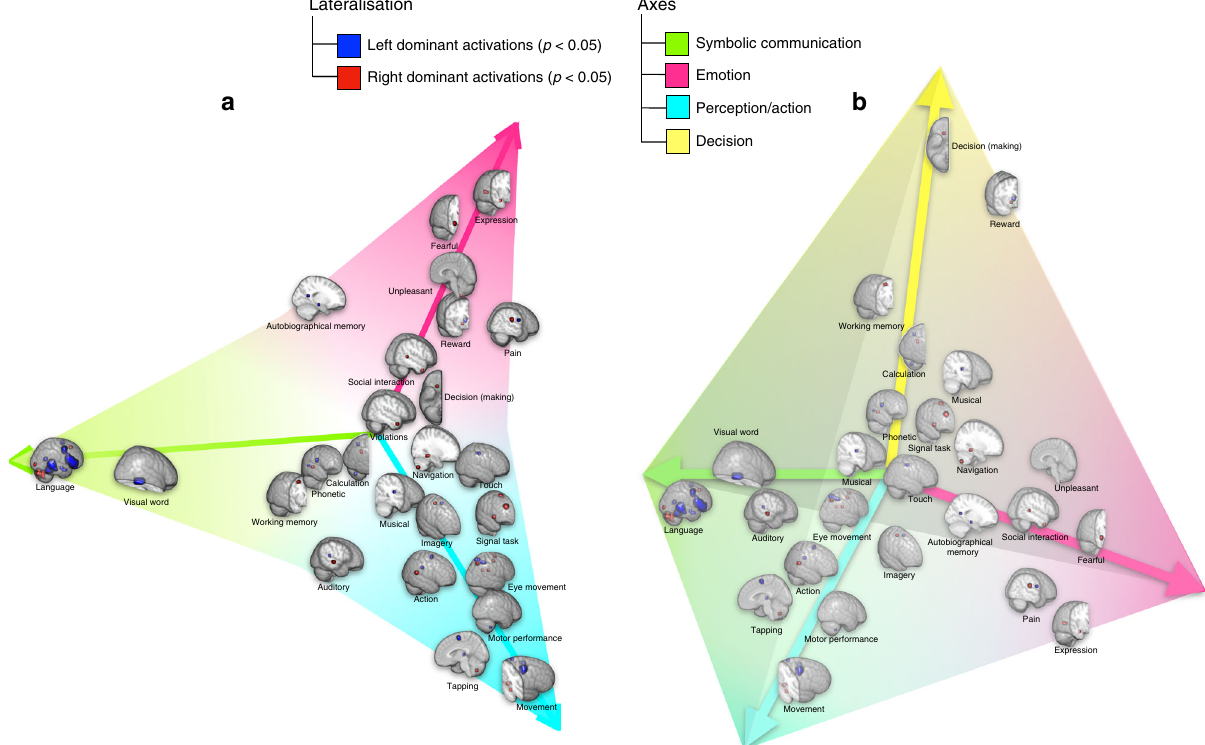
Fig. 1 Low-dimensional structure of functional lateralisation. Embedded in two-dimensional ( a ) and three-dimensional ( b ) space according to similarity in their lateralisation pro fi le (MATLAB interactive 3D fi le available as Supplementary Data 1). See Supplementary Figures 1 and 2 for the spatial embedding of all Neurosynth terms. Here, to provide a graphical summary of all results reported in the section, we plotted the signi fi cantly lateralised components maps, named by the highest-loading terms (Supplementary Table 3), in place of the actual Neurosynth terms (Supplementary Table